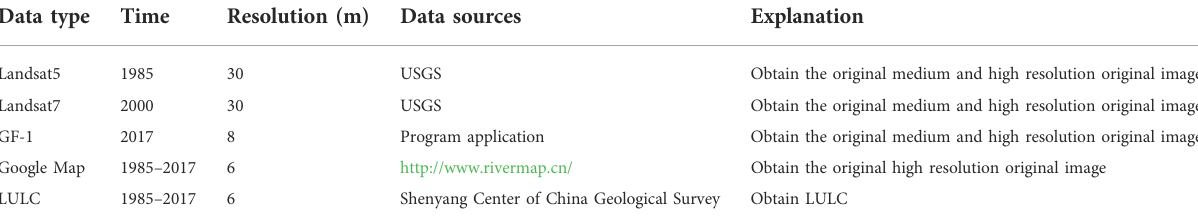
TABLE 1 Data sources and